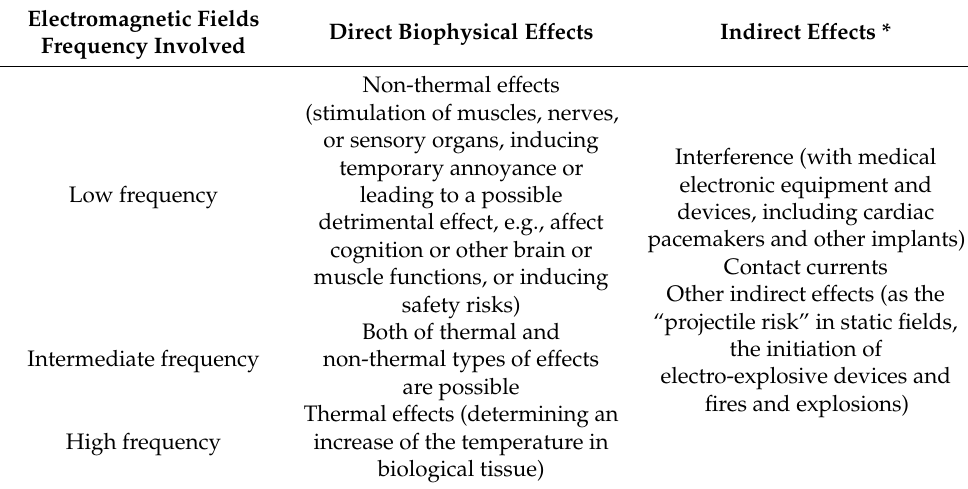
Table 3. Main direct and indirect effects related to electromagnetic fields exposure considered in the Directive